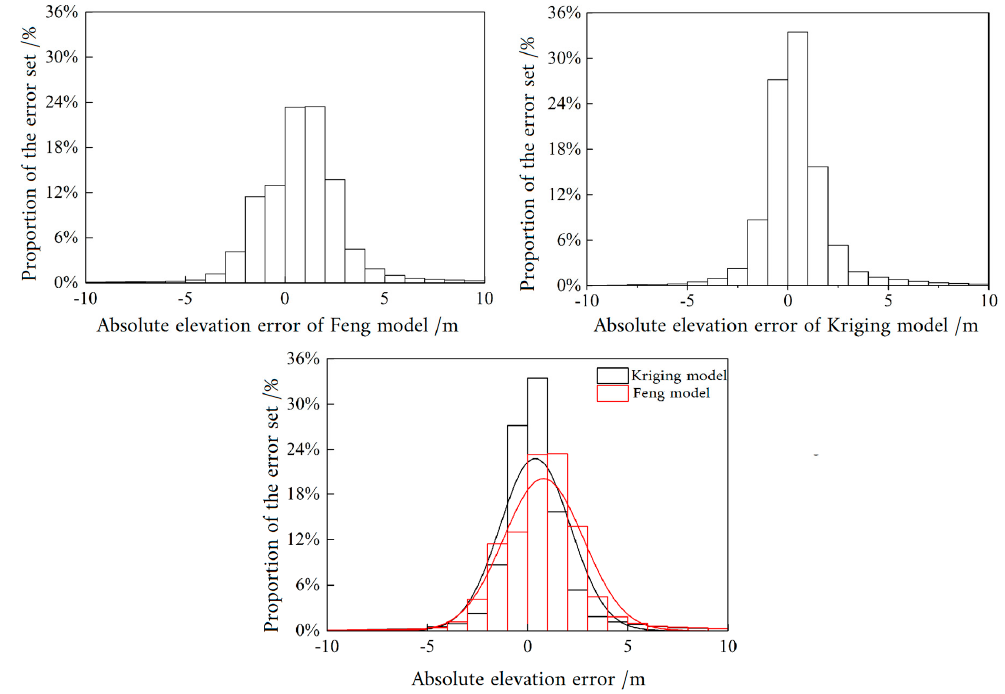
Figure 14. Histogram of absolute elevation error.